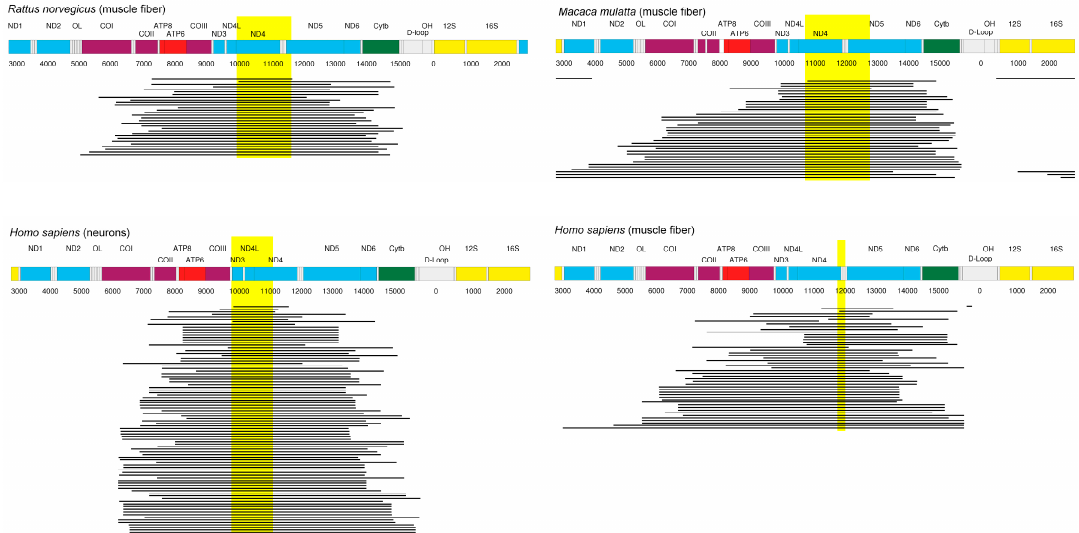
Figure 2. Locations of mtDNA deletions found in rats [2] (top left), rhesus monkeys [3] (top right), and humans [27,28] (bottom). The highlighted area indicates a stretch of mtDNA that is common to all 30 deletions in rat, 38 of 39 deletions in rhesus monkey, all 89 deletions in human neurons (left bottom), and 46 of 48 deletions in human muscle (right bottom). Redrawn from [10].